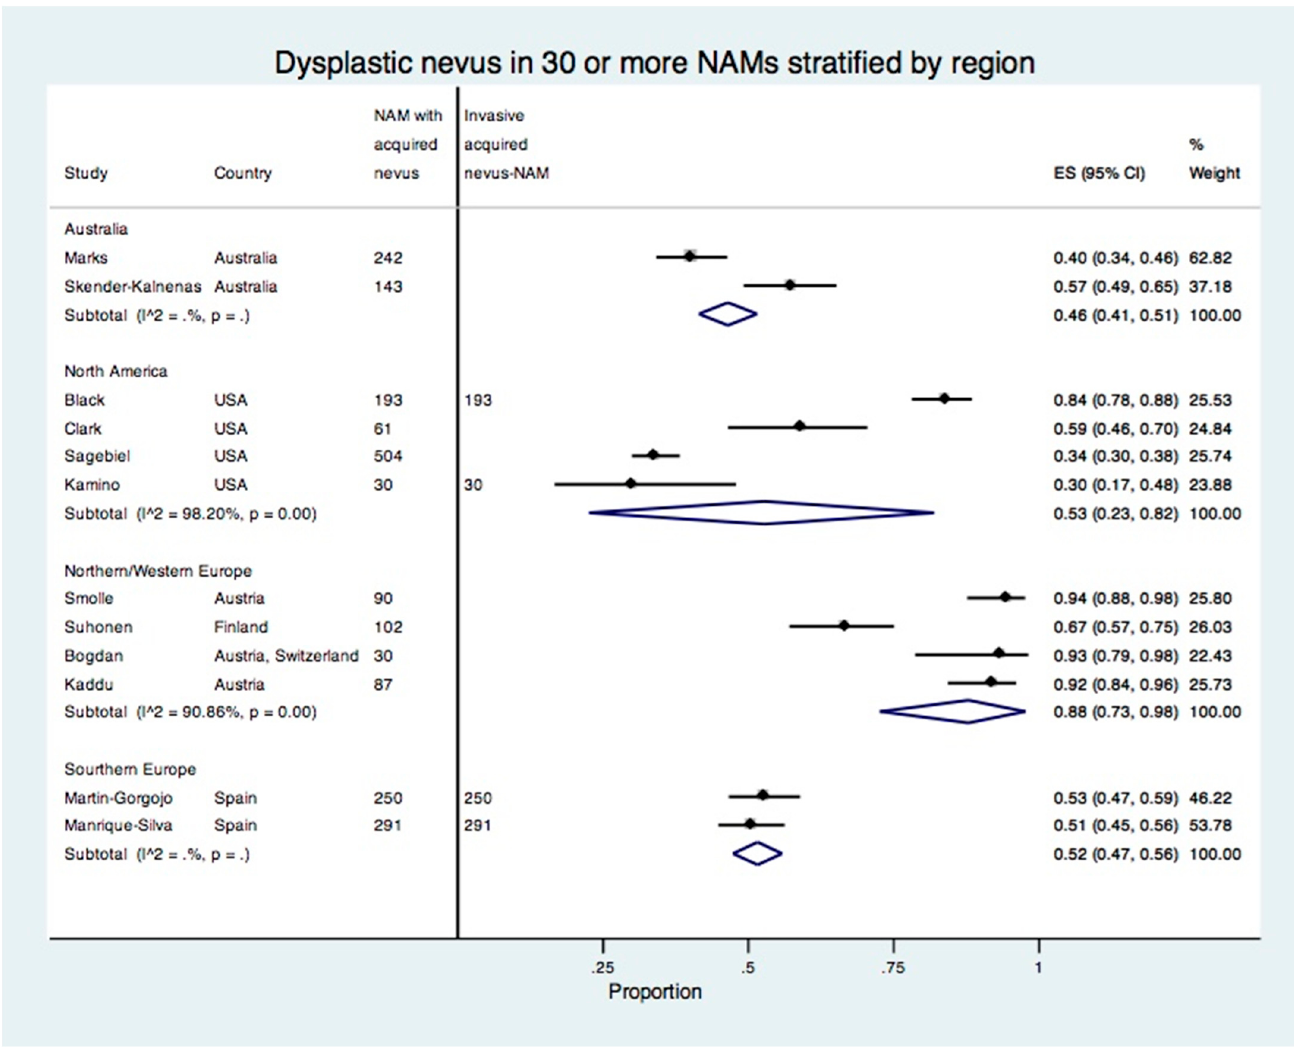
Figure 5. Forest plot of the proportion of dysplastic nevi in studies with 30 or more acquired nevus NAMs stratified by region.